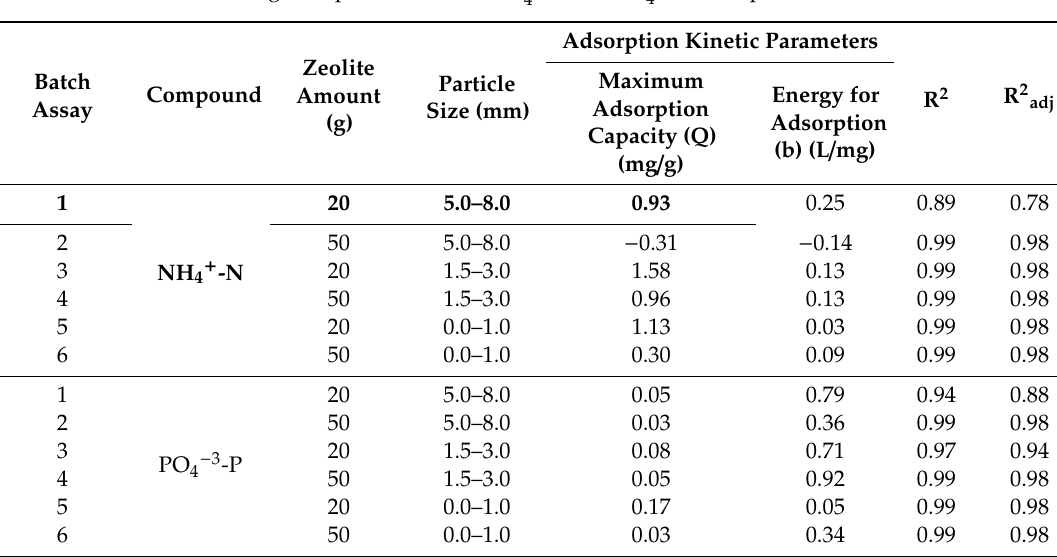
Figure 3. Adsorbed ammonium (mg / g) and phosphate (mg / g) onto zeolite vs. initial concentration in batch assays for the determination of adsorption characteristics. ( a ) ammonium and ( b ) phosphate. − Table 6. Langmuir parameters for NH + -N and PO 3 -P adsorption onto 4 4